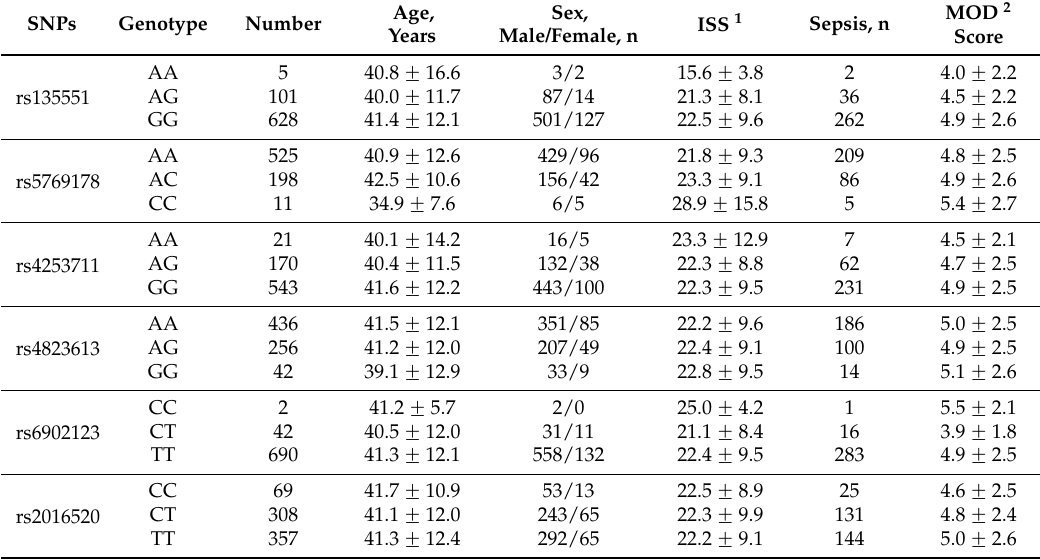
Table 4. Clinical relevance of the selected SNPs among trauma patients in Chongqing District.